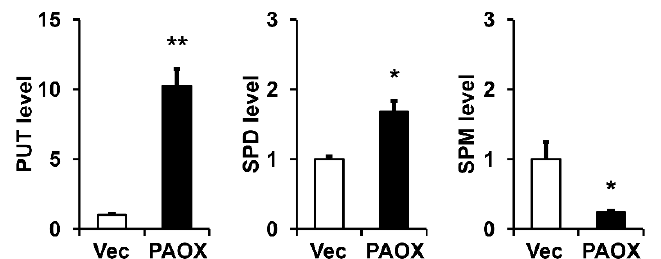
Figure 4. Effect of PAOX expression on polyamine distribution in fibroblasts. Fibroblasts infected with vector viruses or PAOX viruses were incubated in a serum-free DMEM for 24 h, and the levels of polyamines in the cell lysates were analyzed using gas chromatography–mass spectrometry. Graphs depict putrescine (PUT), spermidine (SPD), and spermine (SPM) levels relative to vector-infected cells. Each value represents the mean ± standard deviation of three independent experi- ments. * p < 0.05 and ** p < 0.01 vs. PUT, SPD, or SPM levels in vector control.